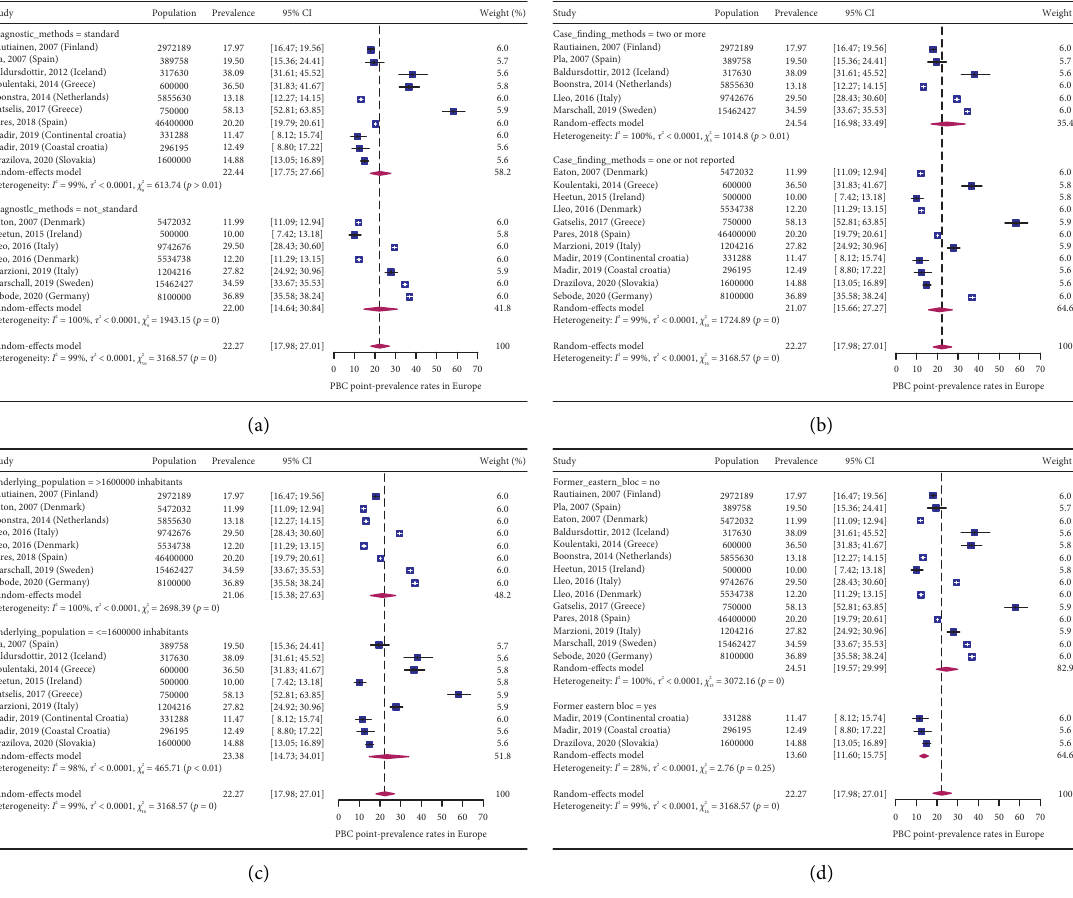
Figure 5: Subgroup analyses of PBC point-prevalence rates. (a) Diagnostic criteria. (b) Case-finding methods. (c) Underlying population. (d) Former Eastern/Western